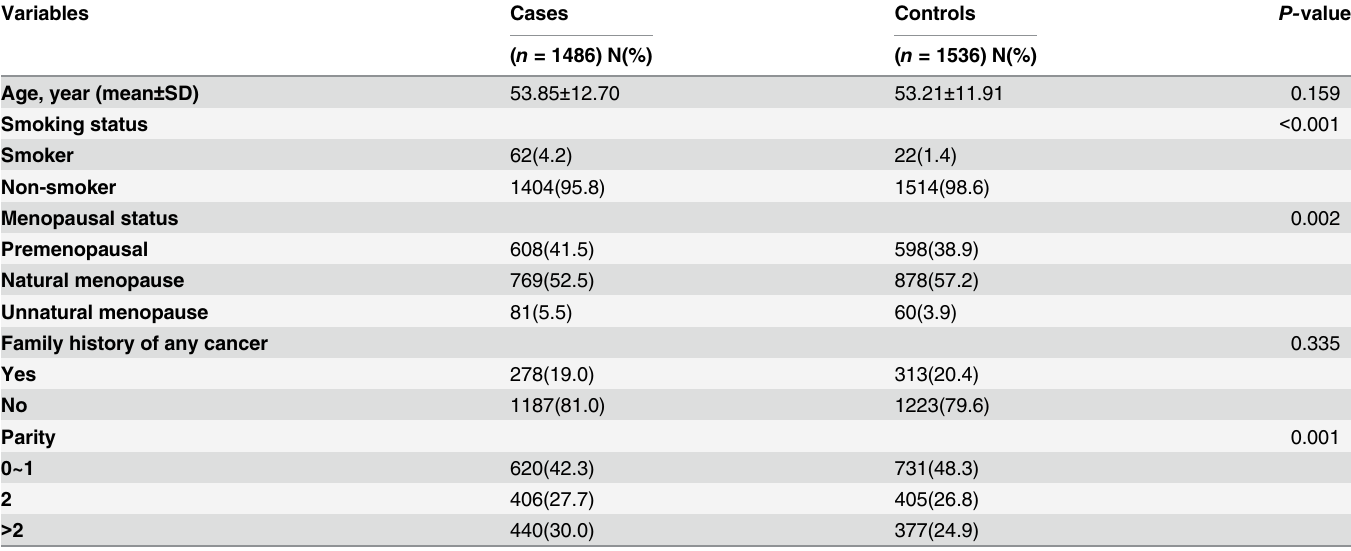
Table 3. Demographic and selected variables between cervical cancer cases and